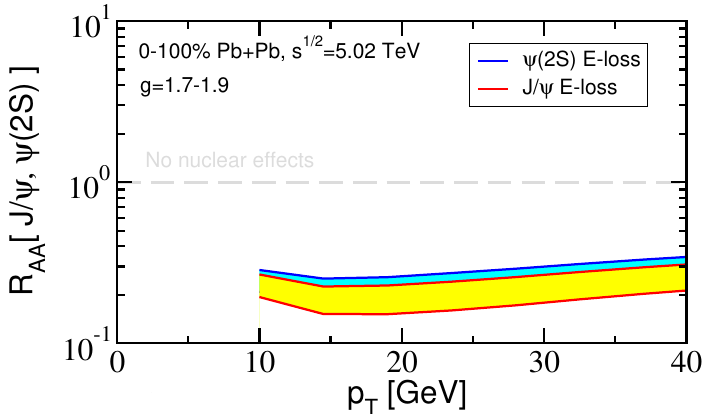
Figure 2 . Suppression of J= (yellow band) and (2 S ) (cyan band) cross sections in minimum bias lead-lead collisions at p s NN = 5 : 02 TeV. The band corresponds to a coupling between the fragmenting parent parton and the medium g = 1 : 7{1 :